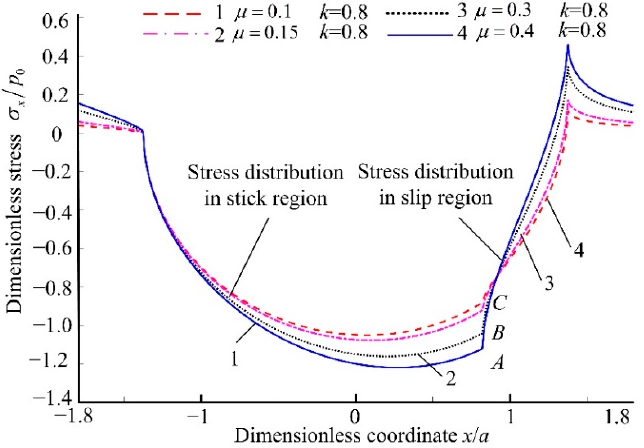
Figure 9. Stress σ x / p 0 for different values of µ.